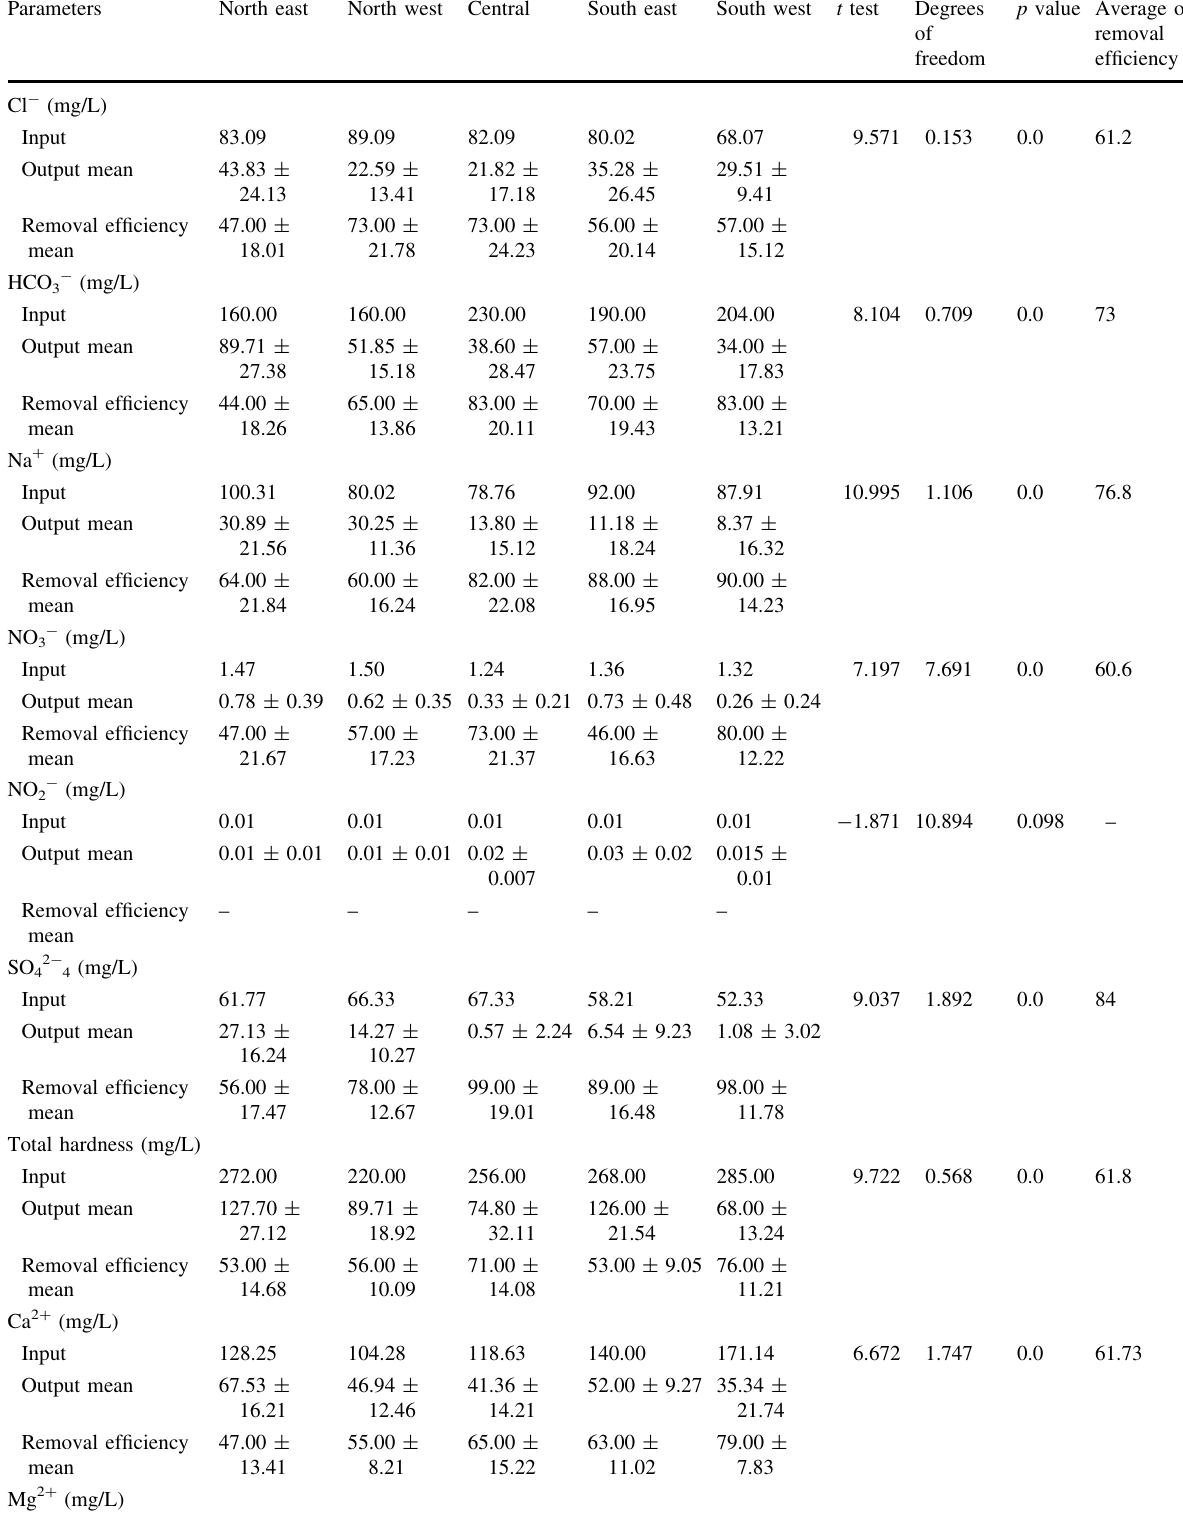
Table 3 Concentrations of samples in each region of Kerman and the influence of household water treatment systems in reducing the concentrations of cations and anions in drinking water (mg/L)